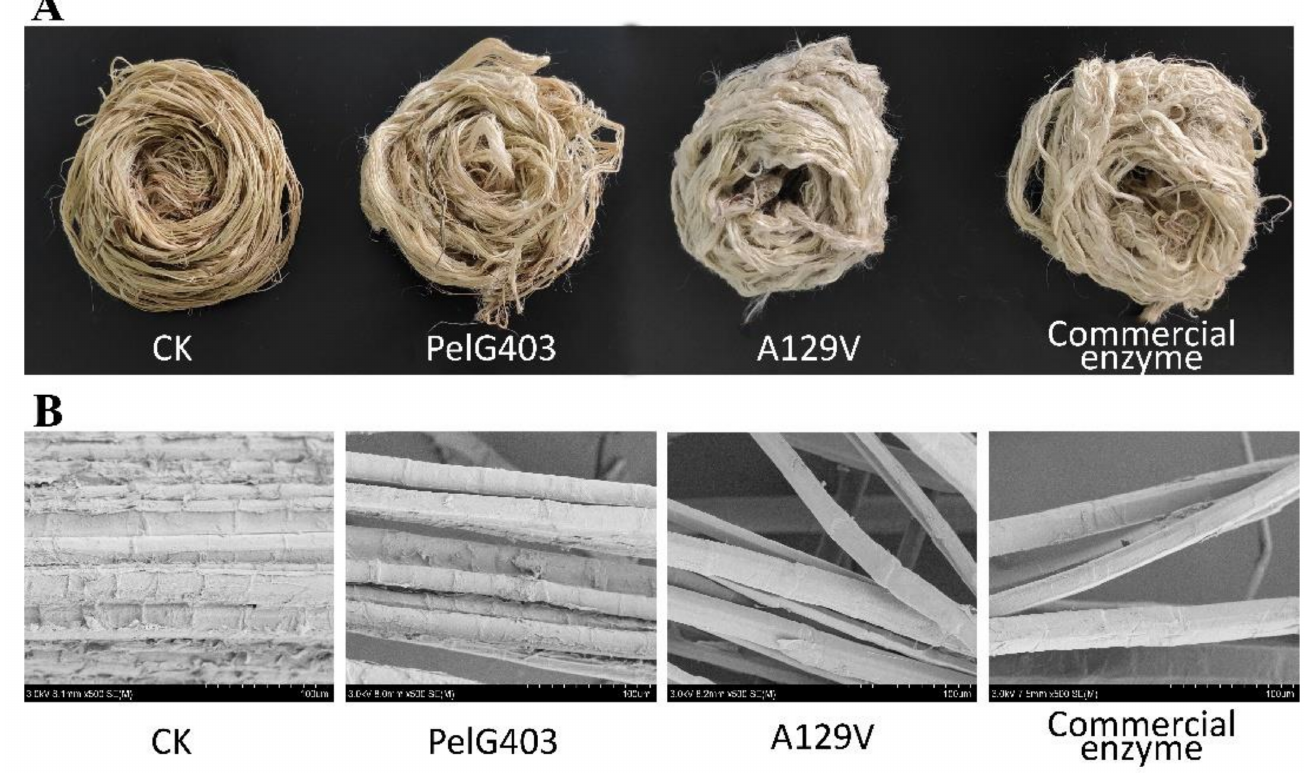
Figure 7. Surface morphology of the treated ramie. ( A ) Surface morphology of the untreated and treated ramie. ( B ) Scanning electron micrograph of the untreated and treated